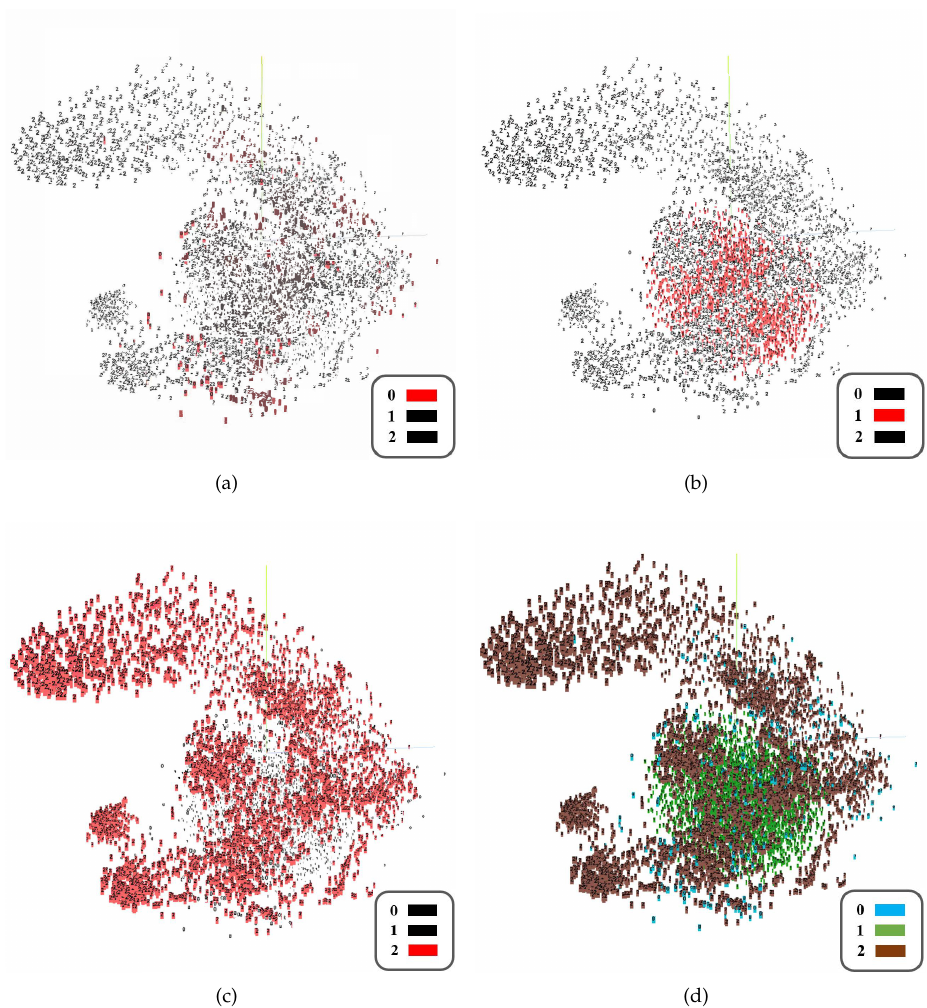
Figure 8. High-dimensional feature visualization results (t-SNE) on EEG DataSet Others_Subject#1. (( a ) shows unlabeled target domain data with tag 0, ( b ) shows generated target domain data with tag 1, ( c ) shows source domain data with tag 2, and ( d ) is the collective display of